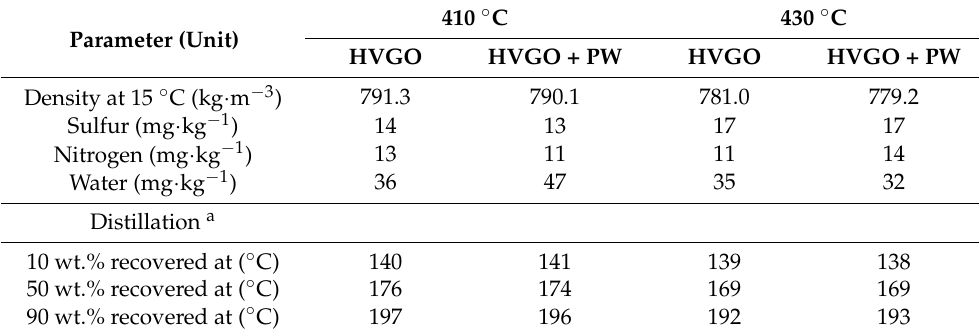
Table 3. Physico-chemical properties of heavy naphtha fractions obtained by hydrocracking of HVGO and HVGO containing 10 wt.% of petroleum wax (HVGO + PW) at various temperatures. Parameter